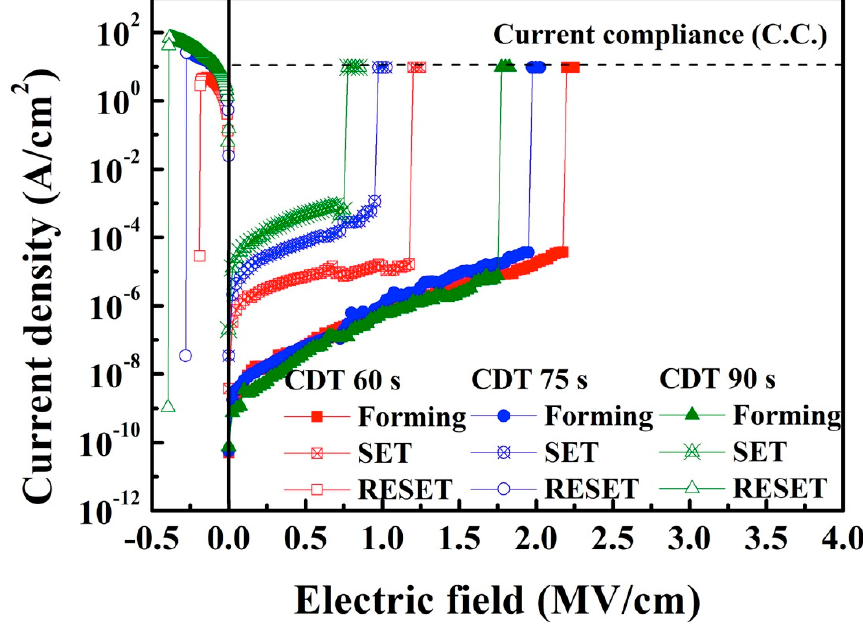
Figure 2. J–E characteristic curves of Cu-CDT ReRAM devices.